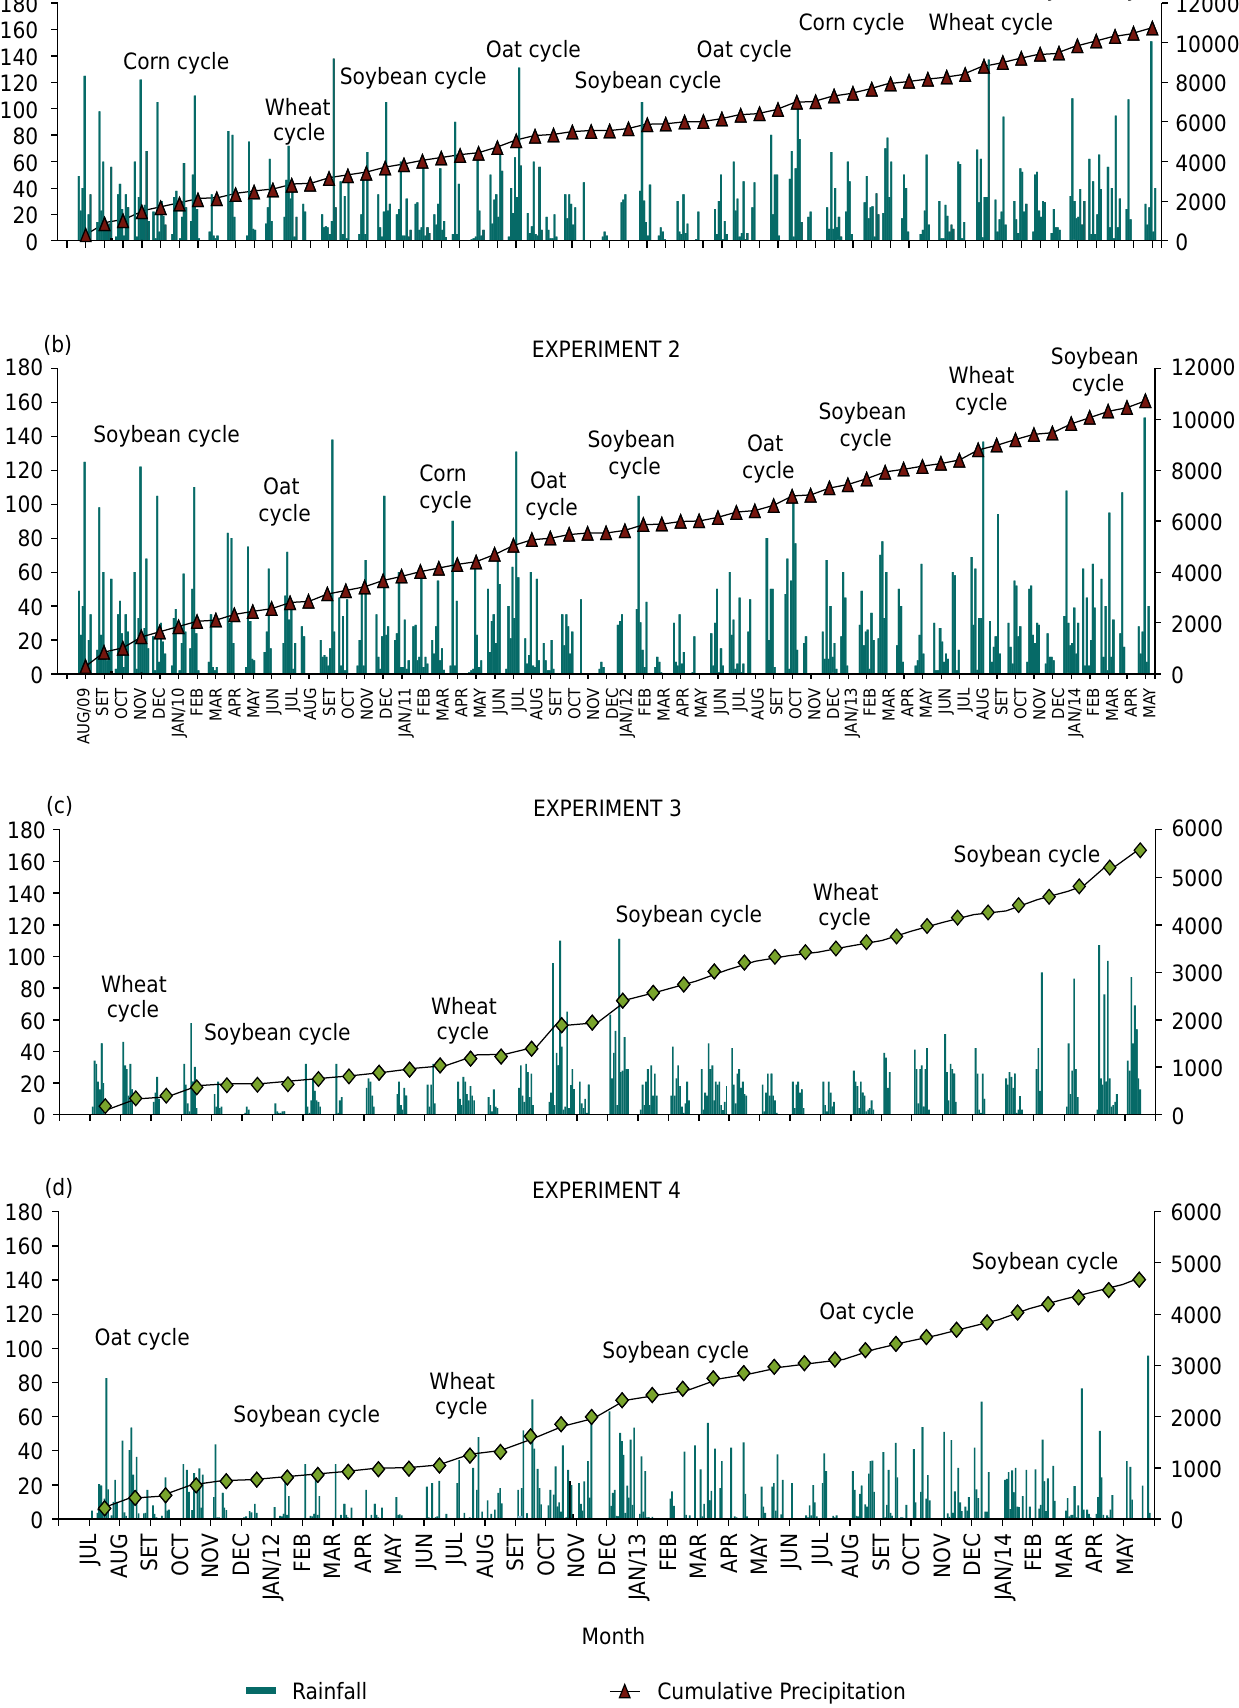
Figure 1. Daily and cumulative precipitation during the experimental period for experiments I, II, III, and IV, and crops evaluated in the experiments. Source: INMET (Instituto Nacional de